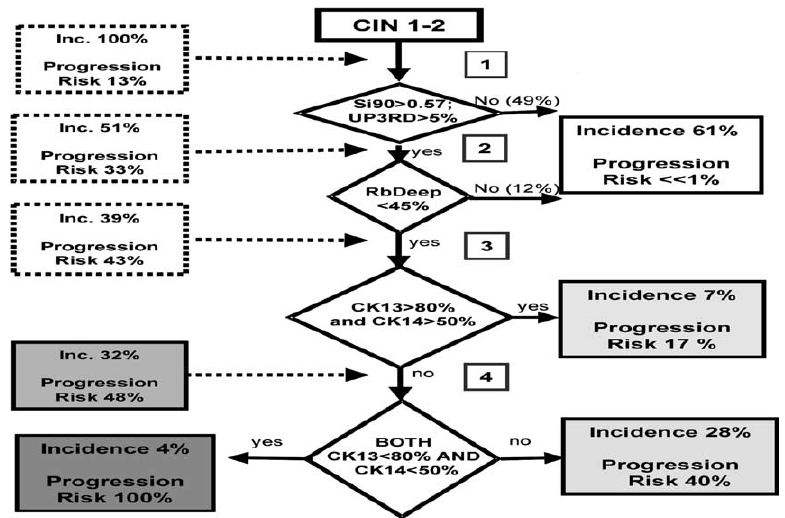
Fig. 1. Progression rates of different Ki67/RbDeep.